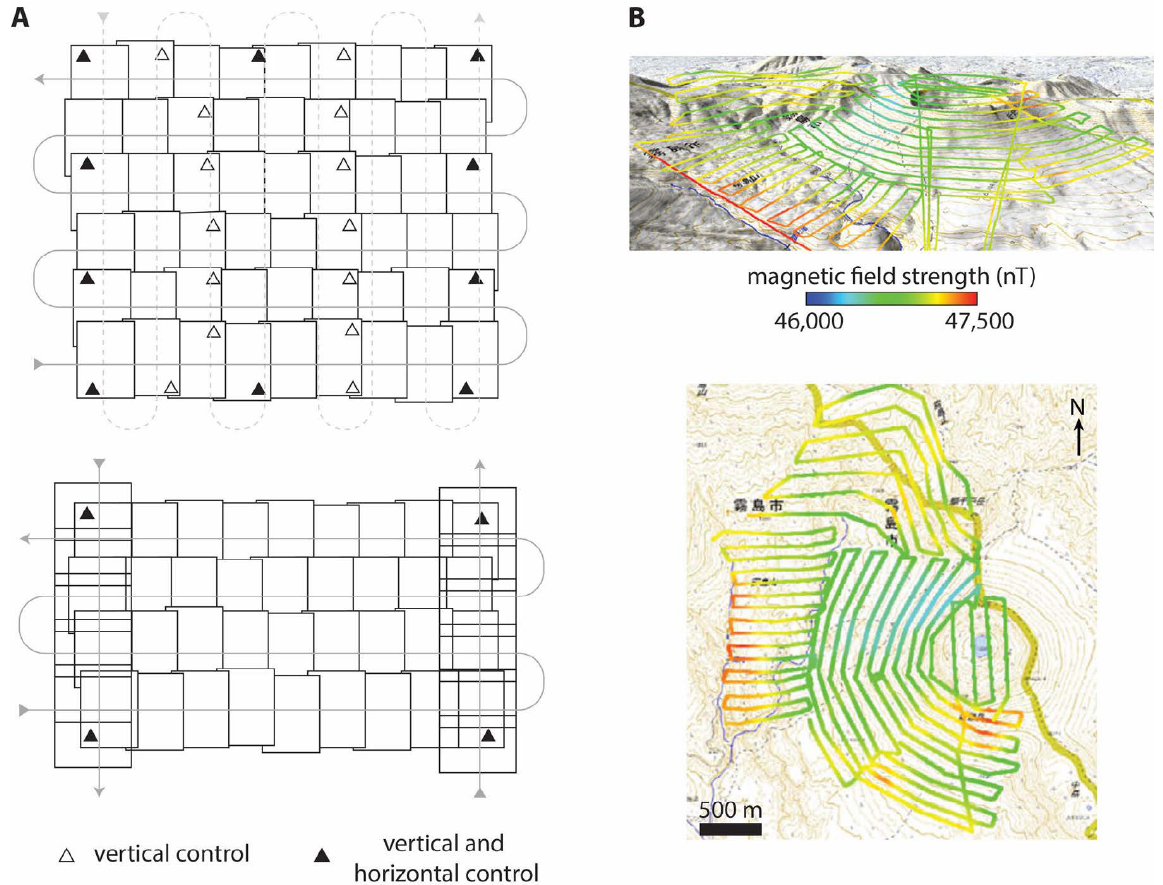
Figure 3: Survey flight paths. [A] Schematic of conventional flight paths (grey) for aerial photogrammetric sur- veys. Surveys comprise two orthogonal grids of parallel flight lines, shown (top) for only ground points (triangle symbols) used as control measurements, or for (bottom) when suitably accurate camera position data are also available. Only a selection of image outlines are shown for the horizontal lines; along-strip image overlap for UAS surveys are often 70–90 %. Adapted from James et al. [2017a]. [B] Visualisation of flight lines from a draped total magnetic field survey over Shinmoe-dake, Japan (2011), coloured by measured magnetic field intensity and viewed (top) obliquely or (bottom) in plan [Koyama et al.